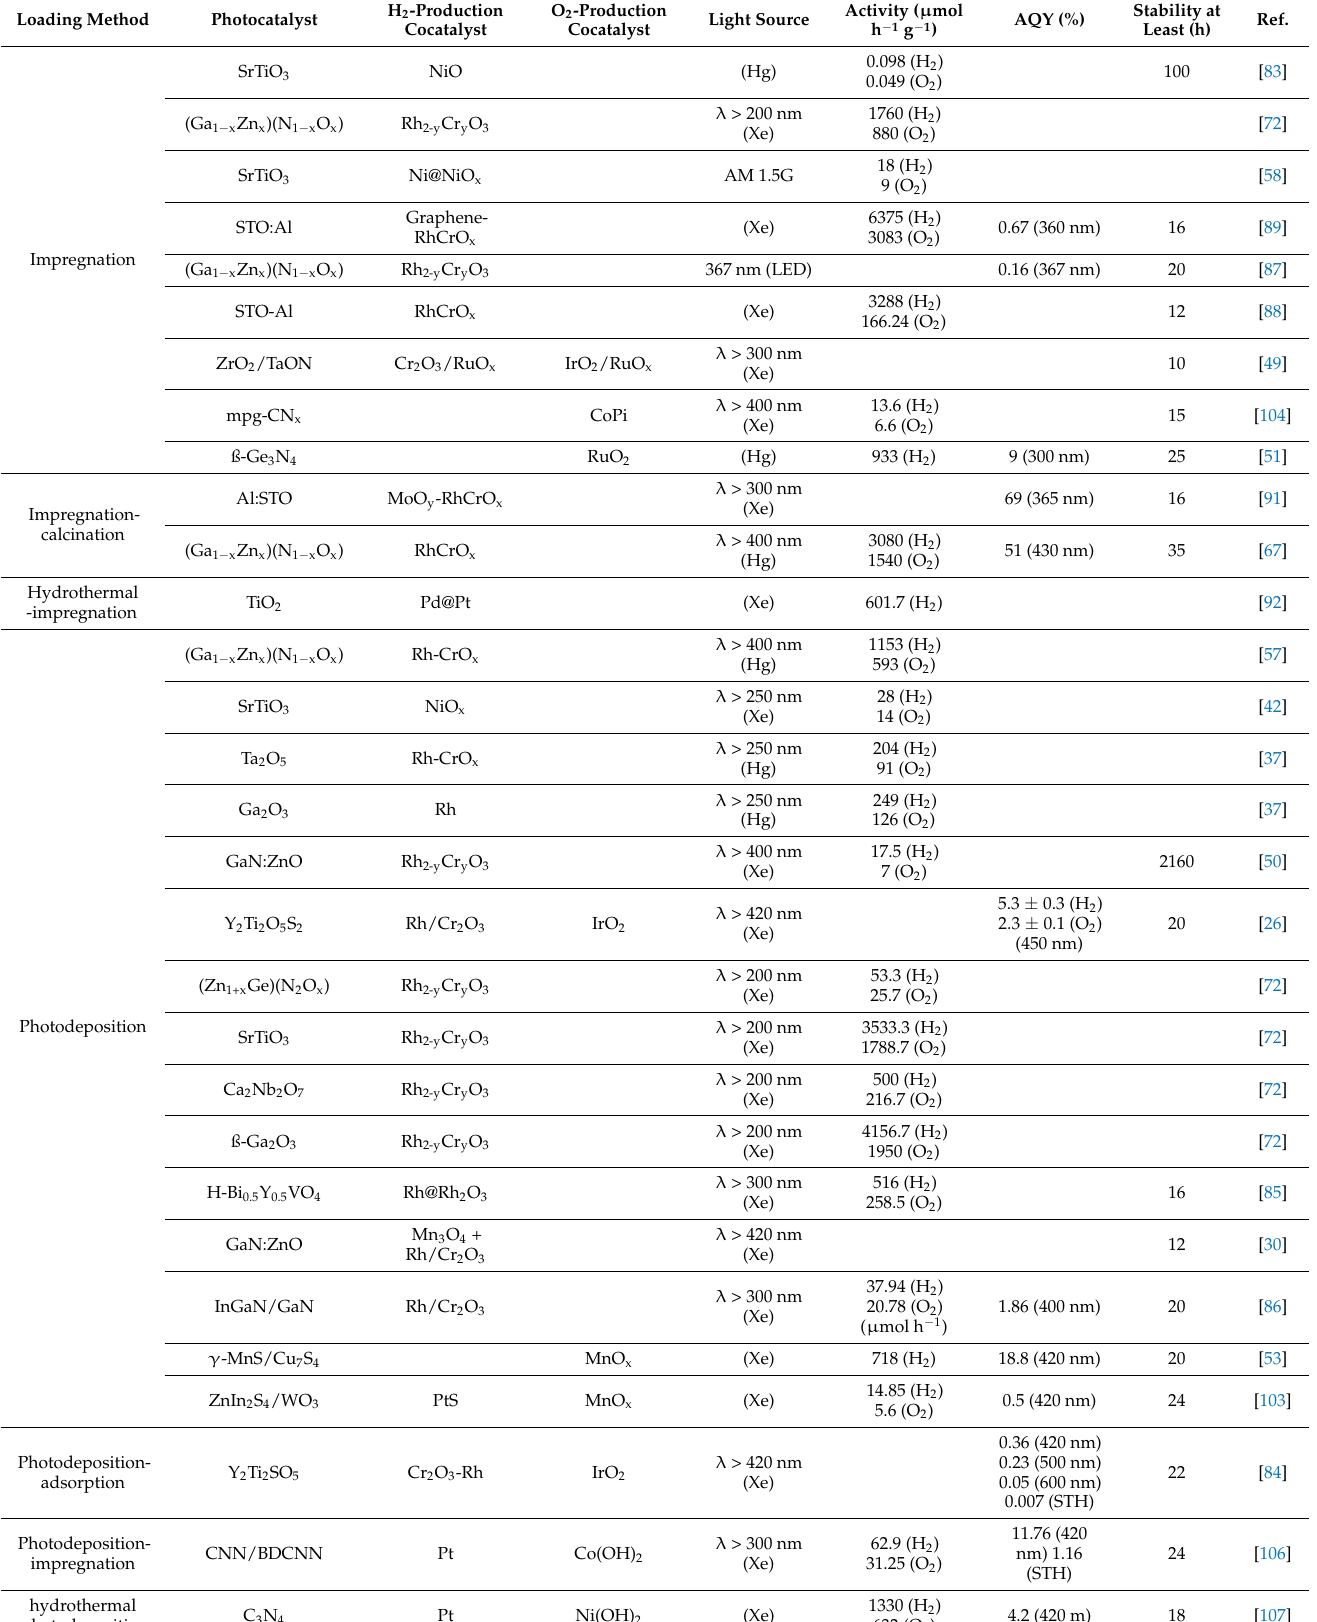
Table 2. The most promising cocatalyst for POWS catalyst with H 2 or O 2